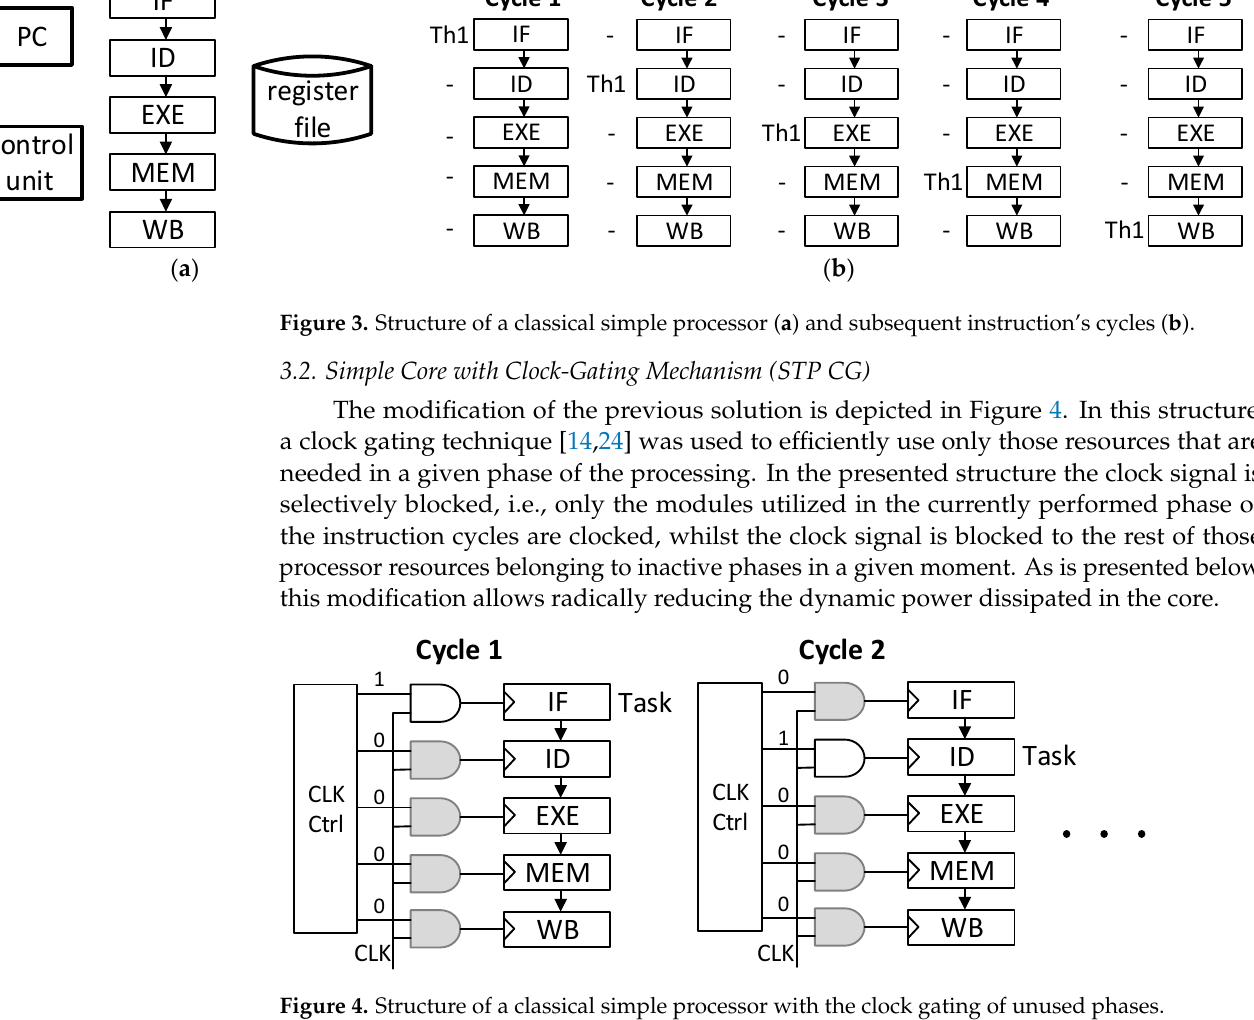
Figure 2. Architecture of a single-core SystemC model of the PRET architecture [3].